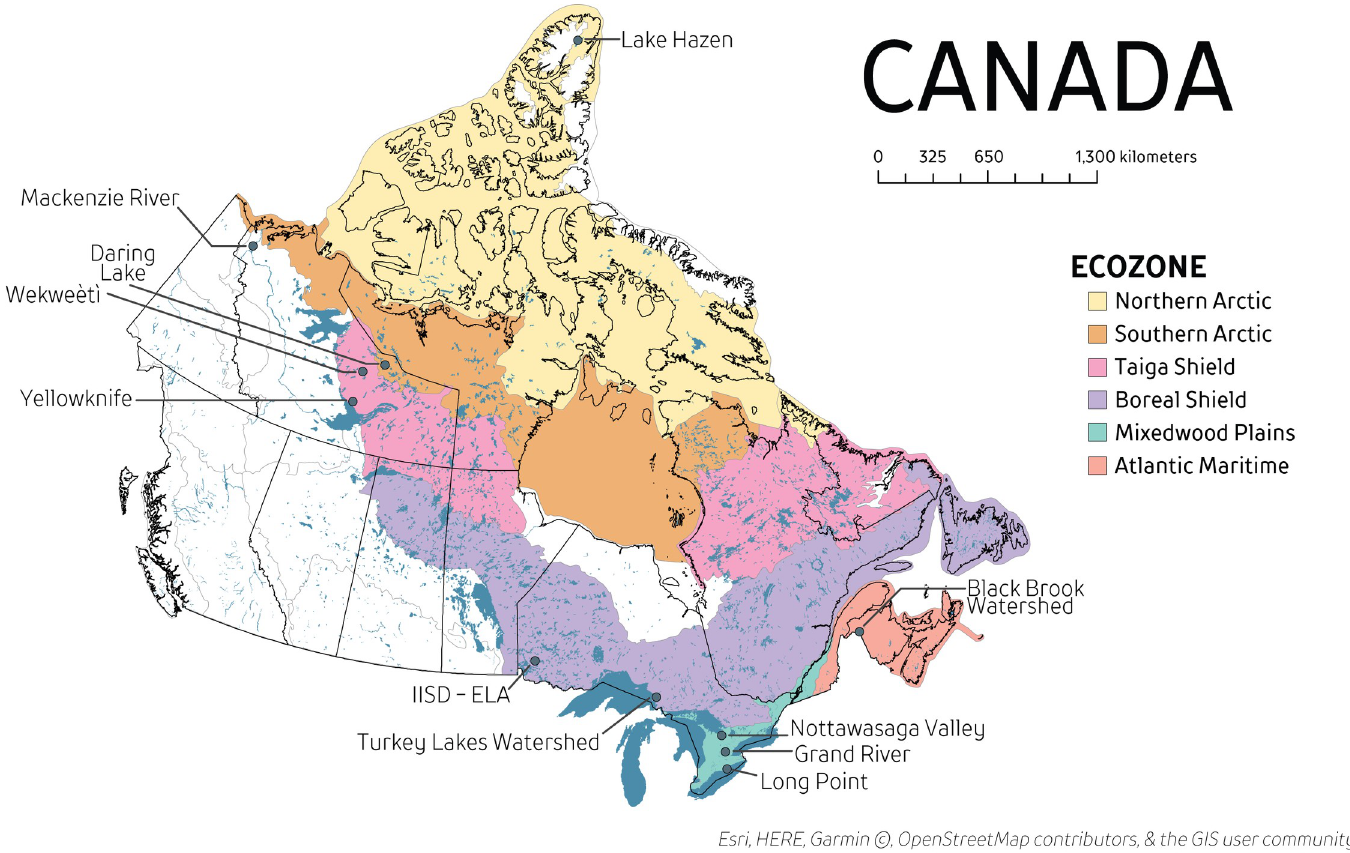
Fig 1. Locations of sampling sites and ecozones. River locations (Grand River, ON; Mackenzie River, NT) are labelled at the mouth of the river.